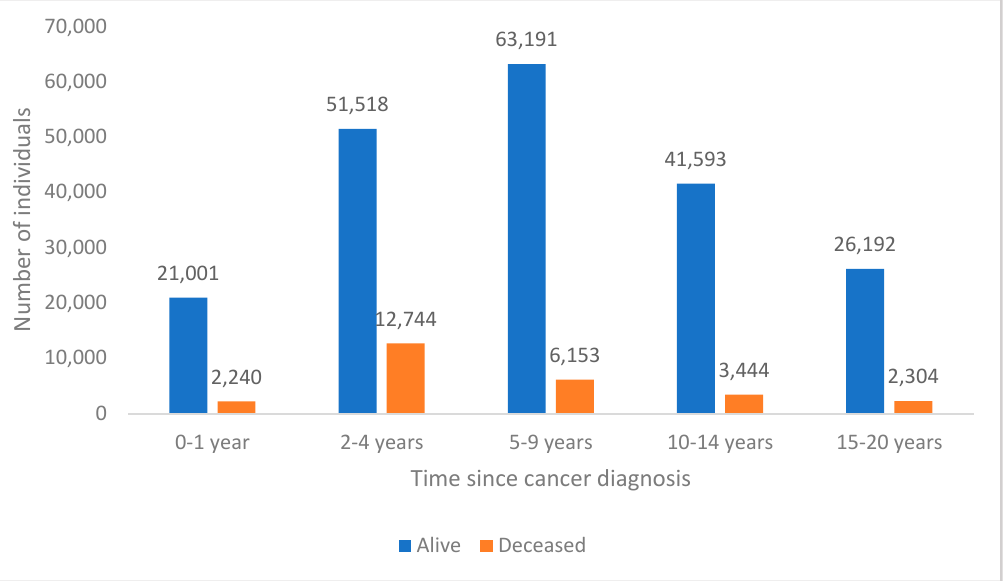
Figure 3. Cancer cohort distribution by time since diagnosis and vital status (N = 230,380). Costs by Time since